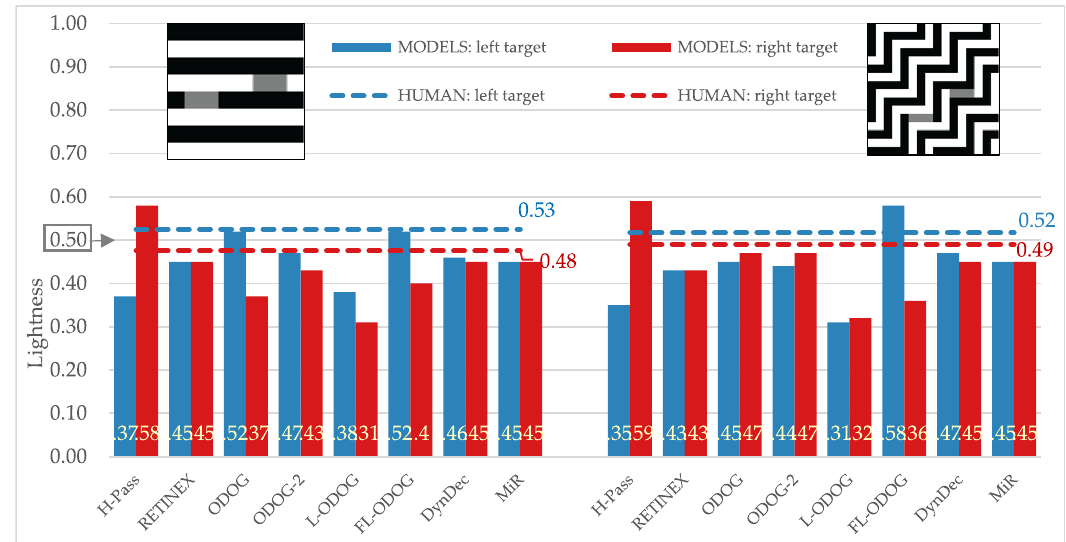
Figure 8. Empirical and model results for White’s and wedding cake illusions. The target lightness value is marked at 0.5 on the Y axis.